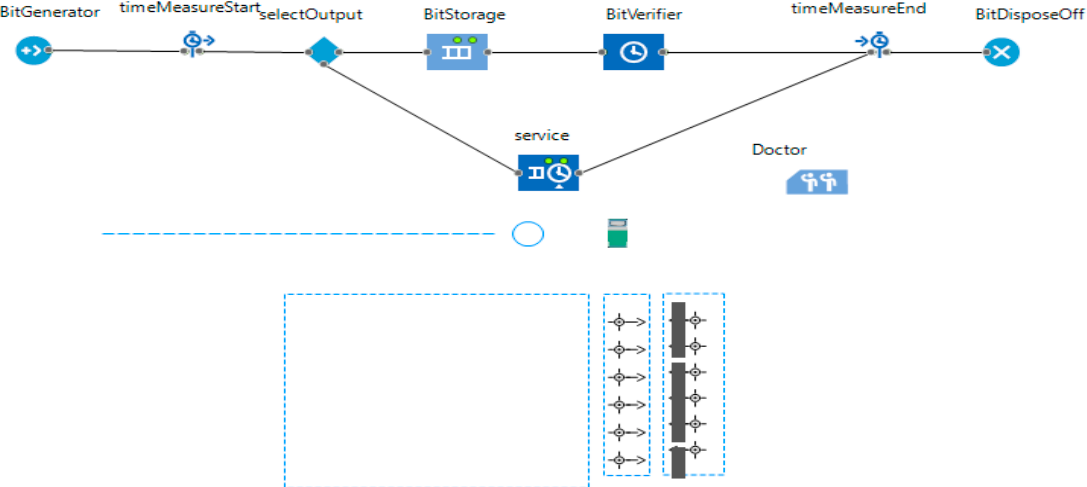
Figure 31. Comparative analysis of change in the number of blocks mined per seconds with a change in block challenges.